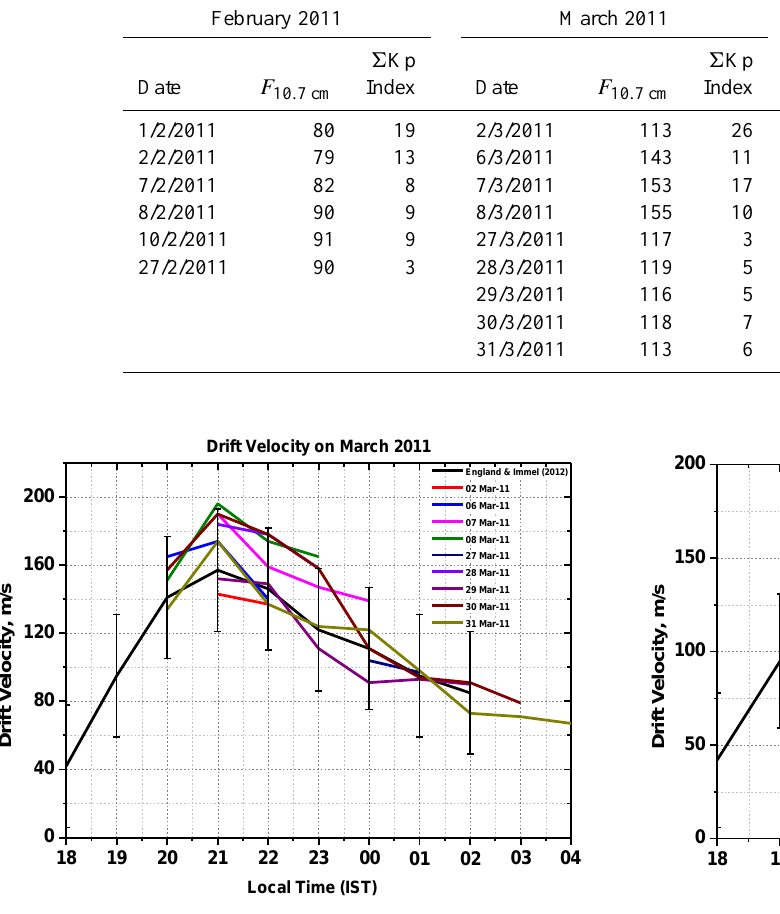
Fig. 5. The daily mean zonal drift velocities of EPBs compared with values of the empirical model for the period of March 2011.